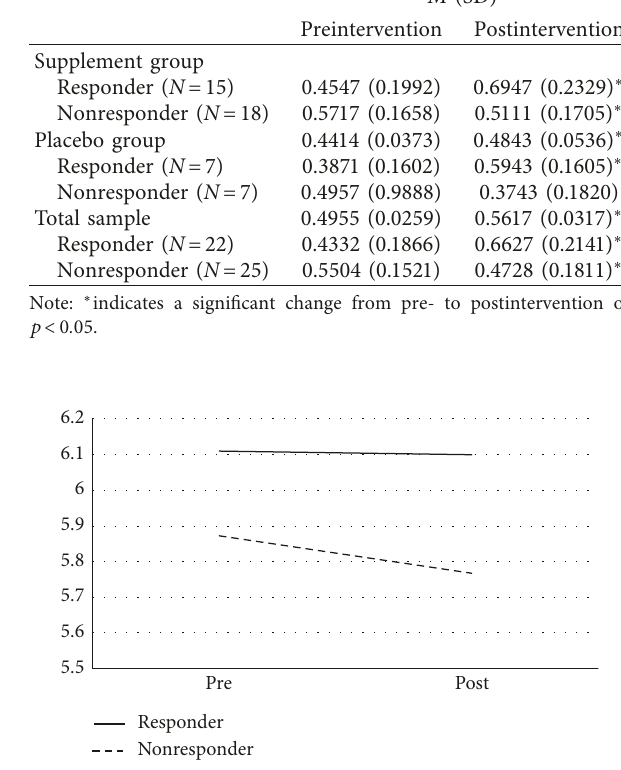
10 5 ) between sup- ×